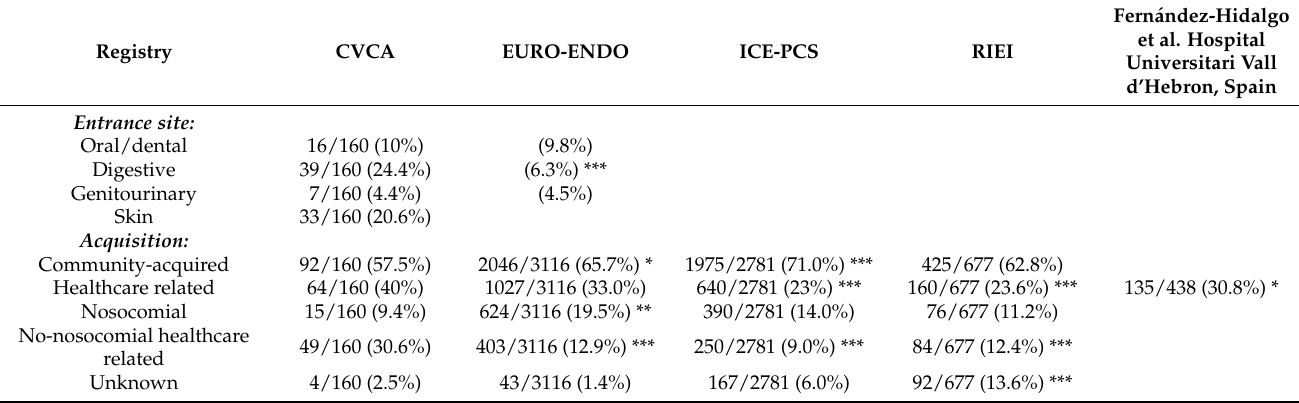
Table A5. Entrance site and